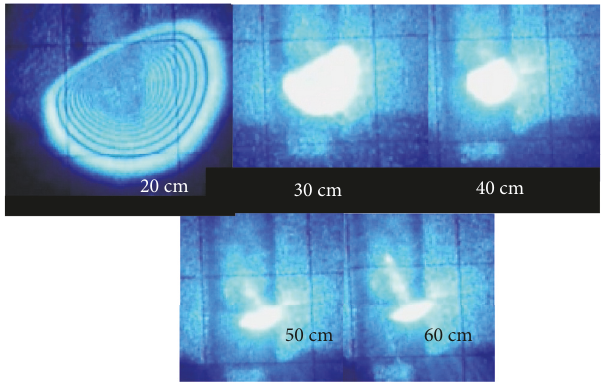
Figure 5: Transformation of the trace profile in a diverging beam with large detuning from the position of the beam waist and the emergence of a fountain from the axial region of the input